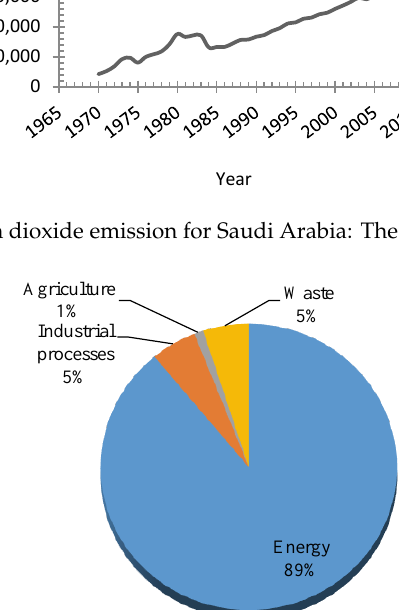
Figure 2. Emissions of greenhouse gases in Saudi Arabia by sector [2,10].